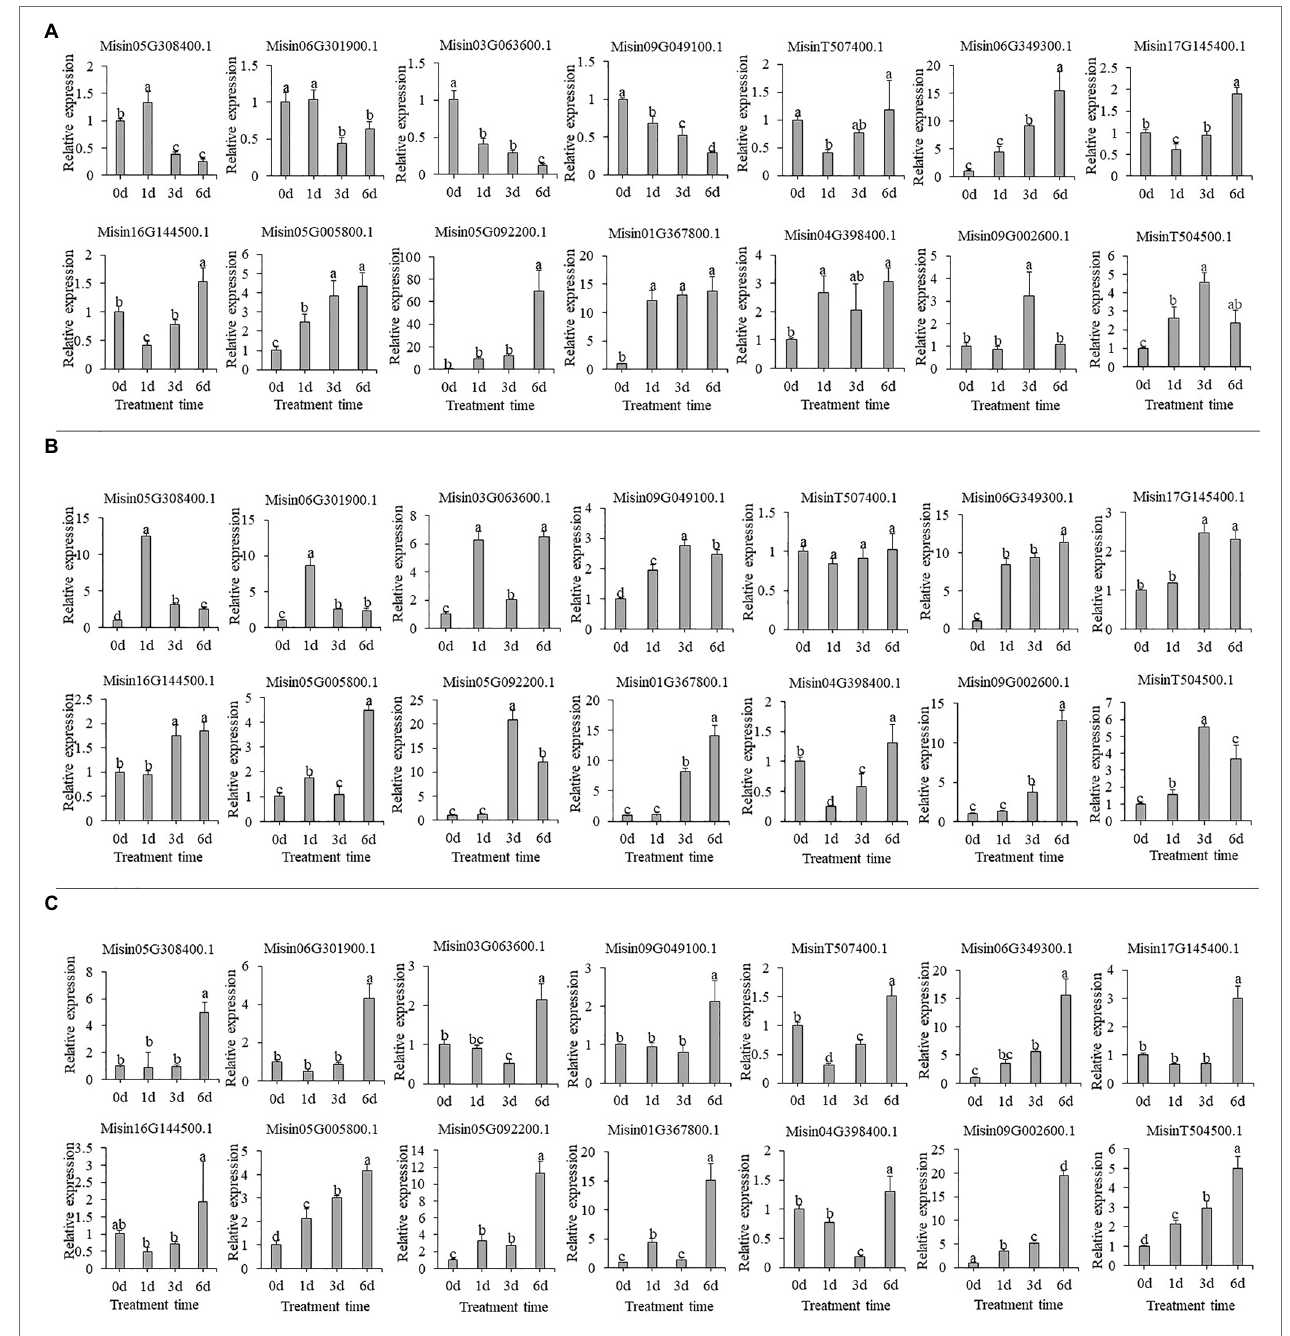
FIGURE 8 | Expression profiles of 14 selected M. sinensis NAC genes in response to (A) Cr (B) Cd and (C) As treatment. Data were normalized to reference gene Unigene33024, and vertical bars indicate SD. No common letter above bar indicates a significant difference by least significant difference (LSD; p <